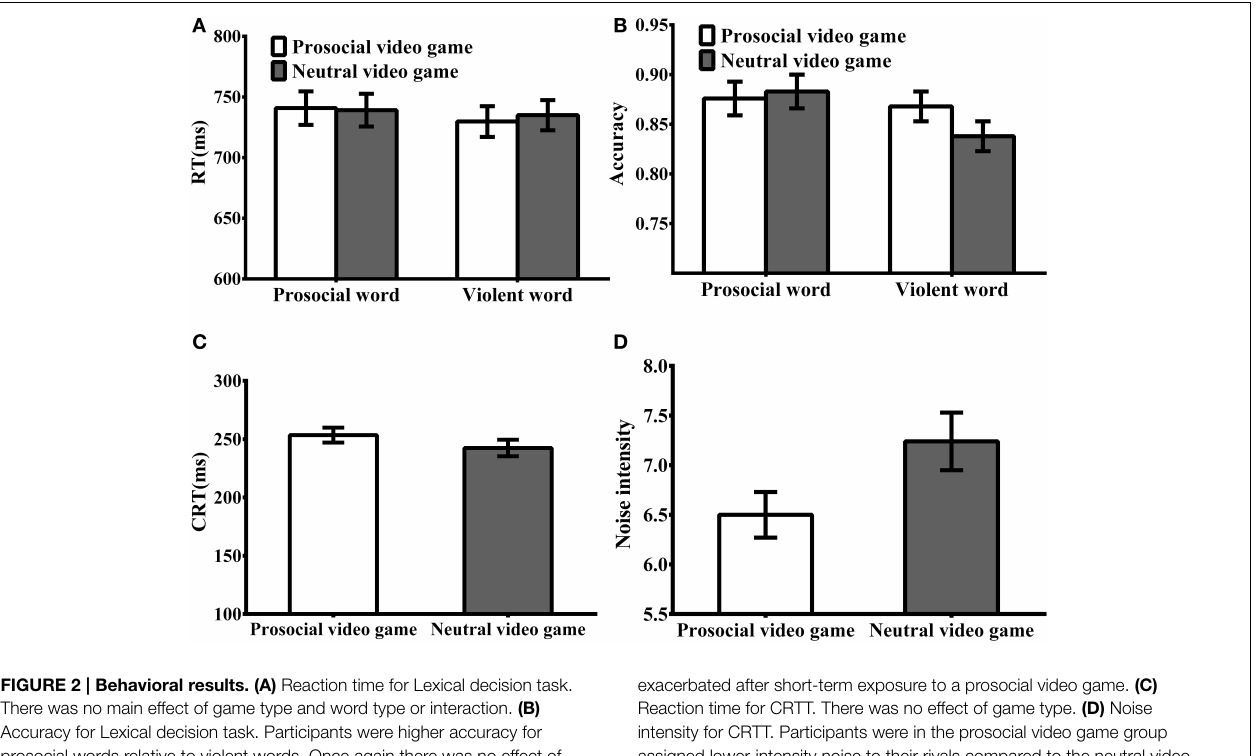
FIGURE 2 | Behavioral results. (A) Reaction time for Lexical decision task. There was no main effect of game type and word type or interaction. (B) Accuracy for Lexical decision task. Participants were higher accuracy for prosocial words relative to violent words. Once again there was no effect of game type; however, there was a reliable interaction such that people were more accurate at identifying the violent words and this effect was